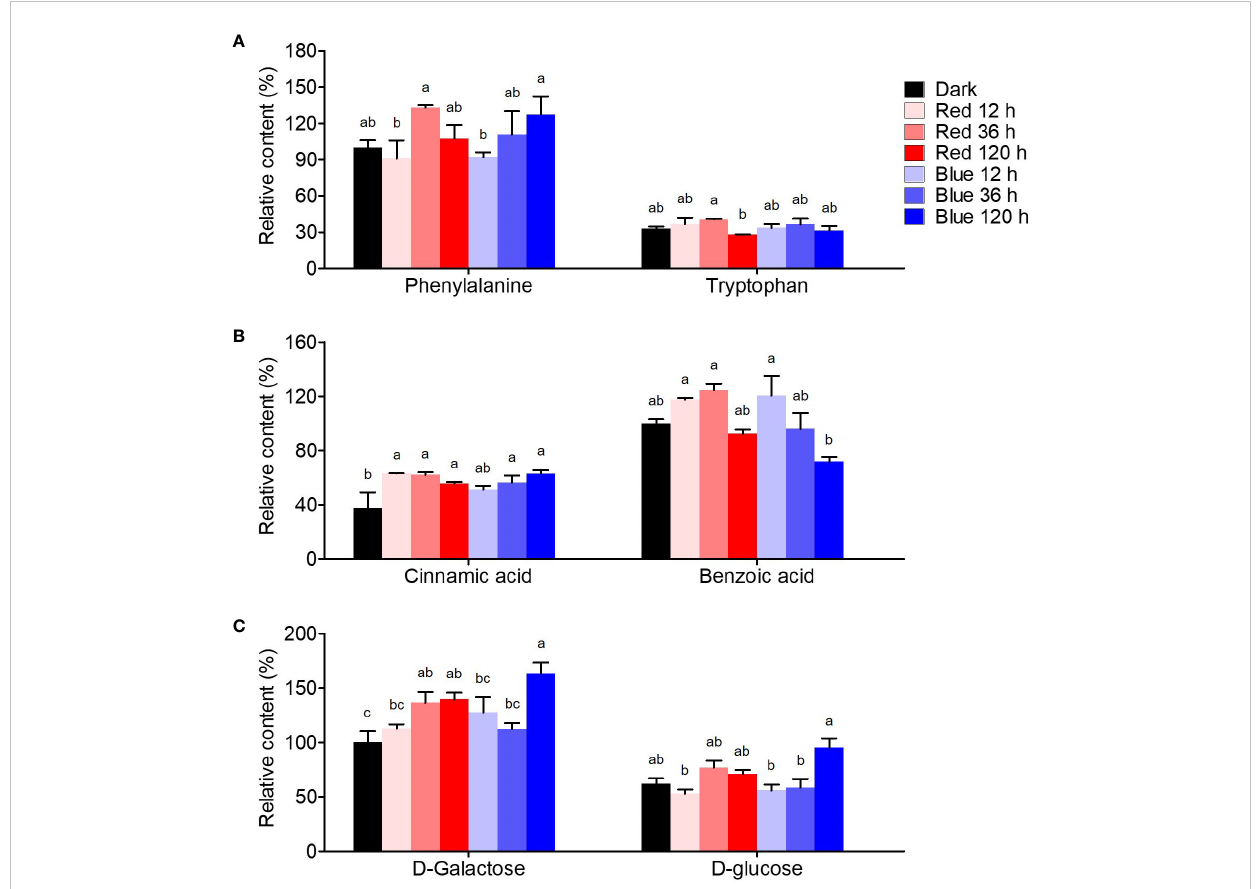
FIGURE 5 Flavonoid synthesis-related metabolites, including amino acid (A) , phenolic acid (B) , and free sugar (C) . The content of amino acid, phenolic acid, and free sugar was expressed as relative content (%) of phenylalanine, benzoic acid, and D-galactose of dark-grown seedlings in each metabolite group, respectively. Different letters (a – c) above the bars in each metabolite indicate signi fi cant differences at p < 0.05 by Tukey ’ s studentized range (HSD)